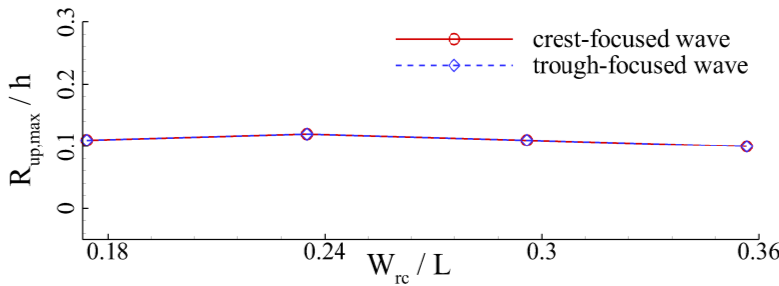
Figure 61. Maximum wave runup height versus the ridge width.